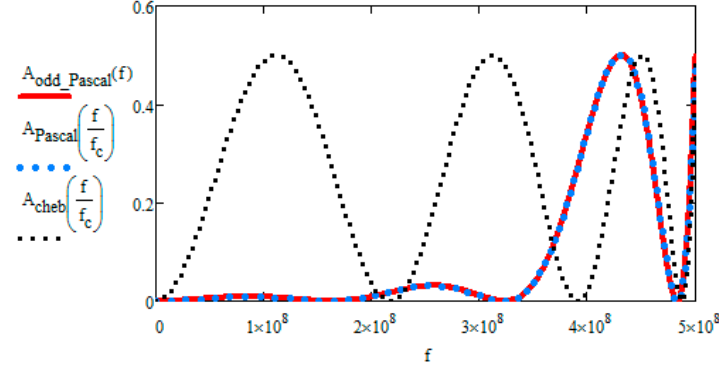
Figure 9. Passband of the Pascal and Chebyshev filters.